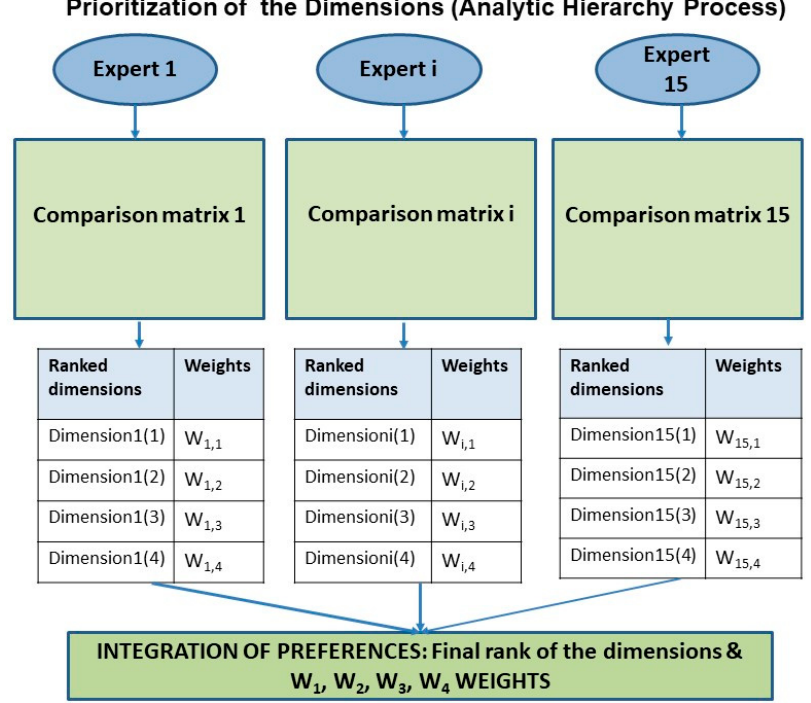
Figure 2. Structure of the dimension prioritization process.